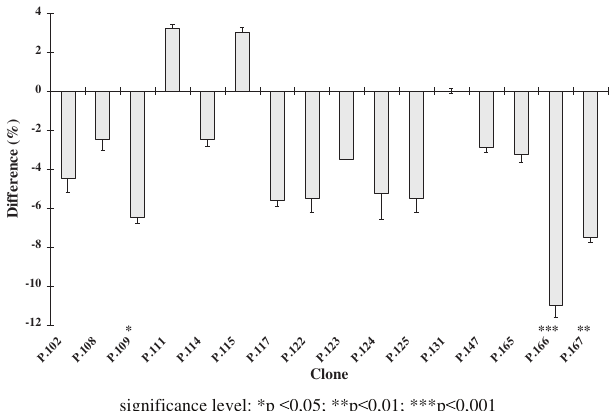
Figure 8. Evaluation of the profile analysis of the wine of the 2011 vintage produced from the P. 147 clone of ‘Kadarka’ (Szekszárd – Batti